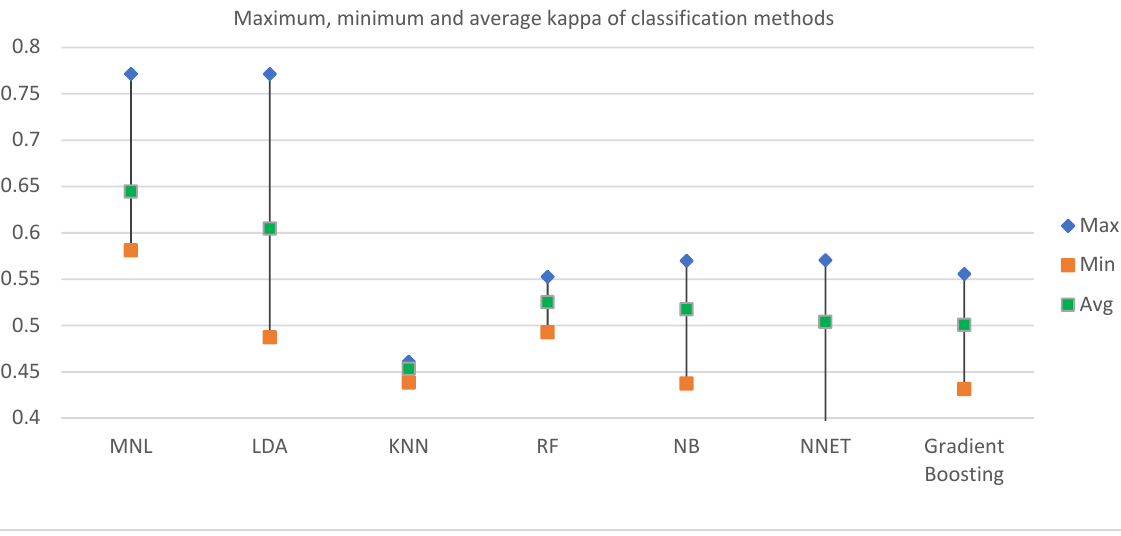
Figure 4. Maximum, minimum, and average kappa of classification methods.